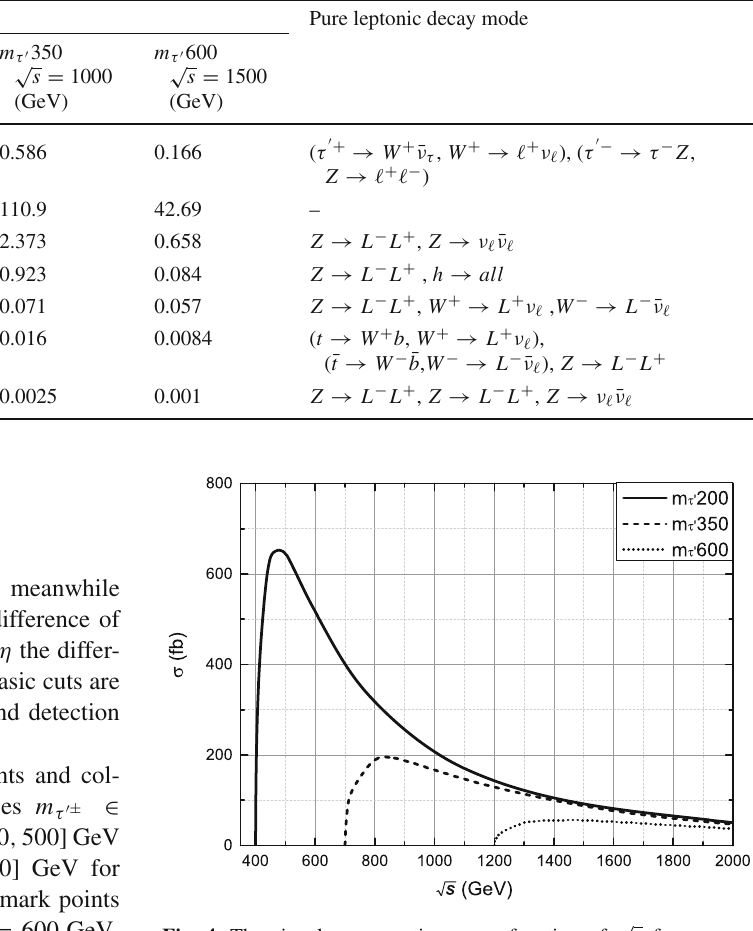
Fig. 4 The signal cross sections as a function of 200 , 350 , 600 GeV